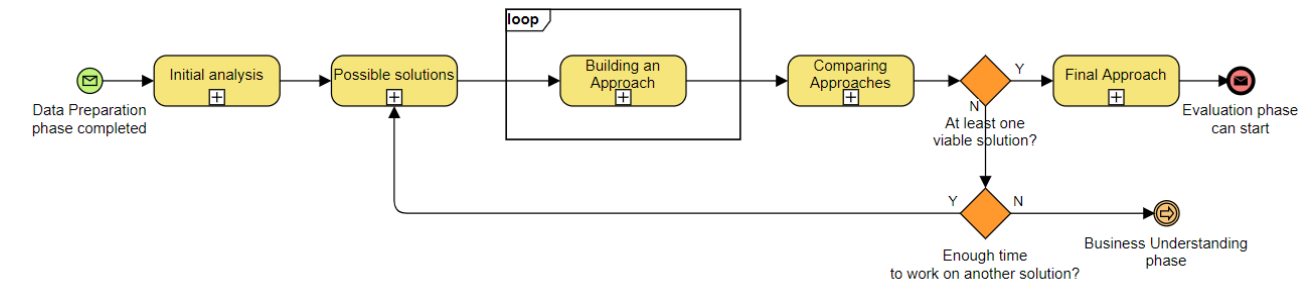
Figure 3. Top diagram proposal for the ‘Modelling’ phase.